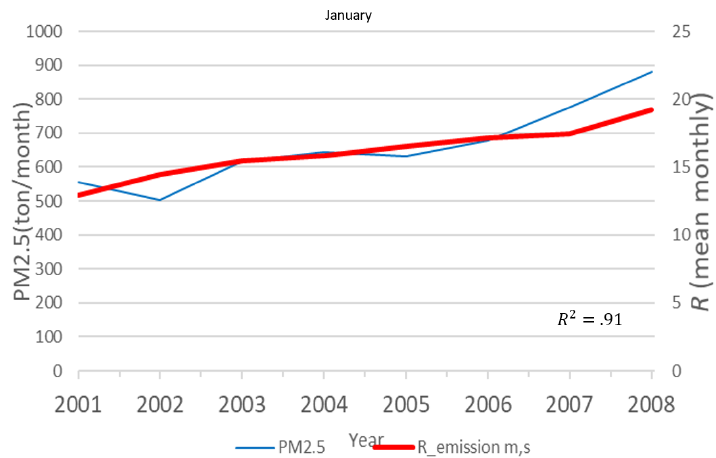
Figure 10. Comparison of annual trend of primary PM2.5 emissions from REASv2 inventory and R em due to residential, commercial, industrial and vehicles in New